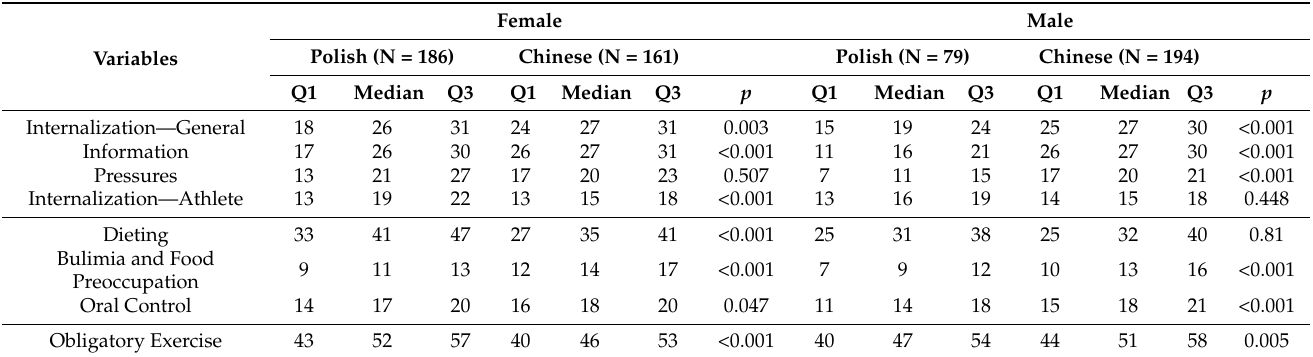
Table 1. Comparative analysis of the young Polish and Chinese male and female groups according to the variables included in the research